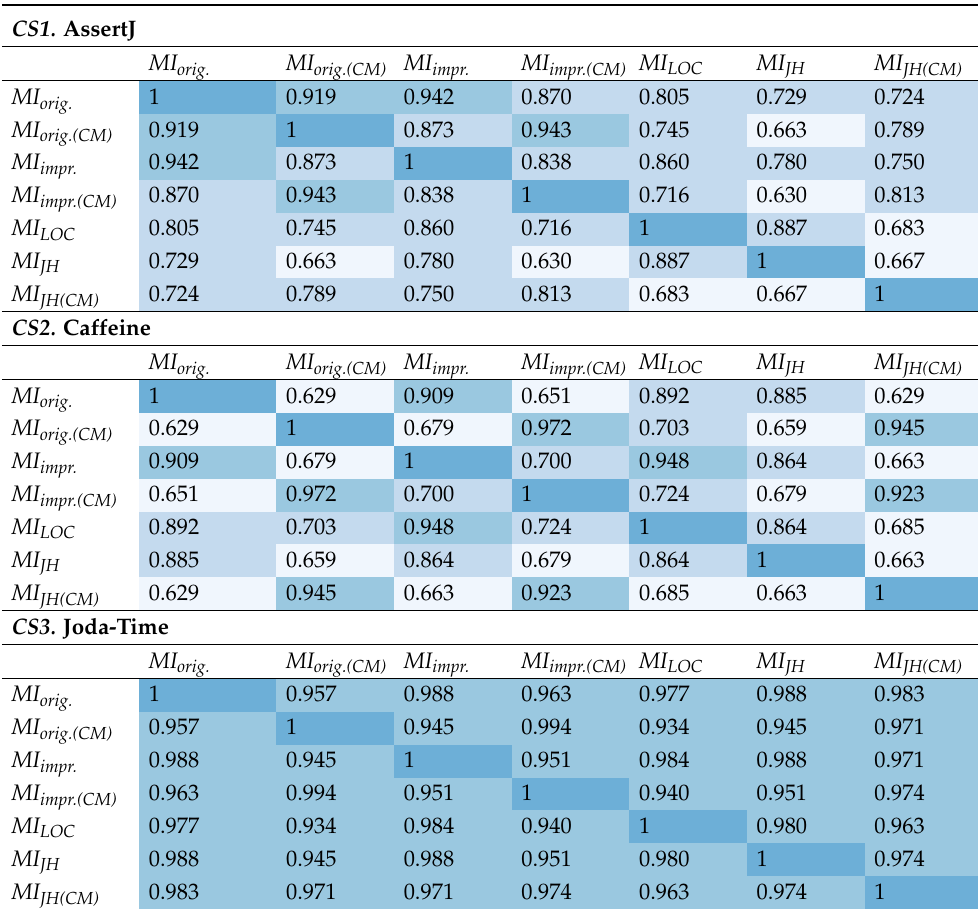
Table 12. Correlation analysis using Kendall’s τ -b Correlation Coefficient (all reported